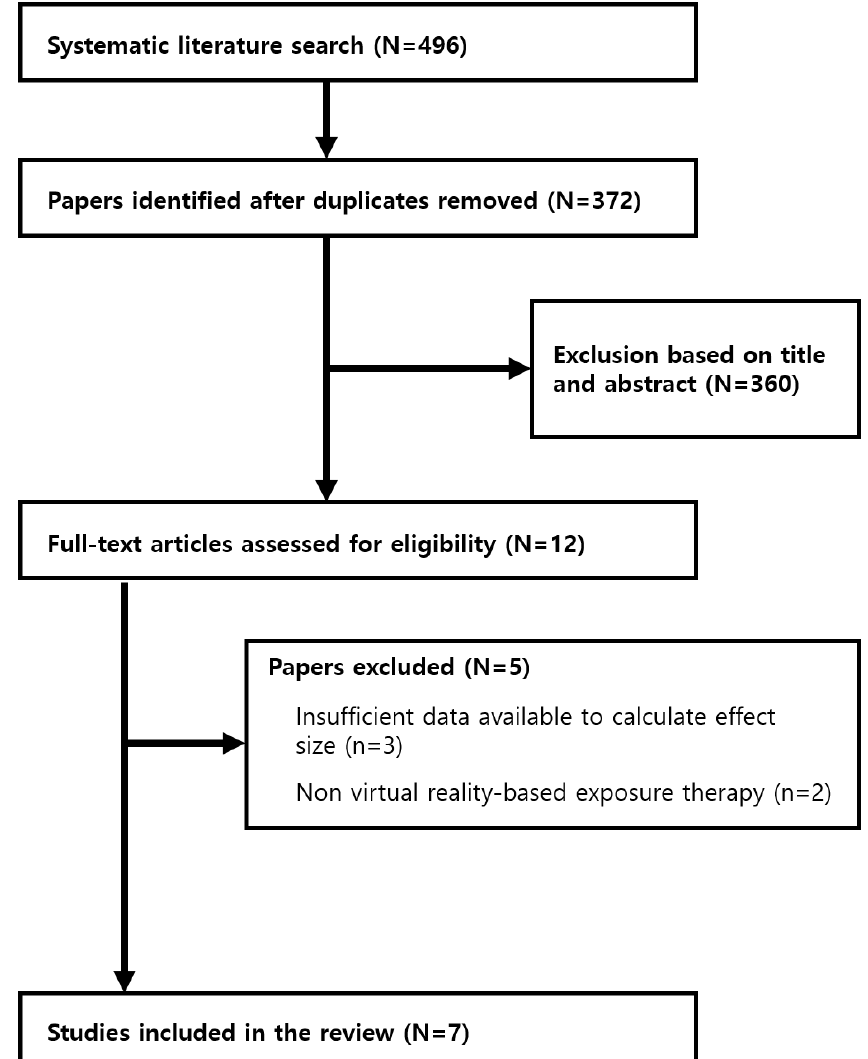
Figure 1. Flow chart of the study selection process.